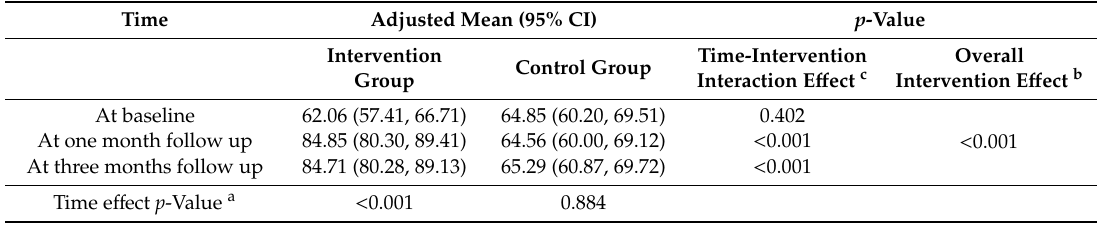
Table 4. Time e ff ect, overall intervention e ff ect and time-intervention interaction e ff ect for RM ANOVA of the M-DCSD knowledge score, using an ITT approach ( n = 136).